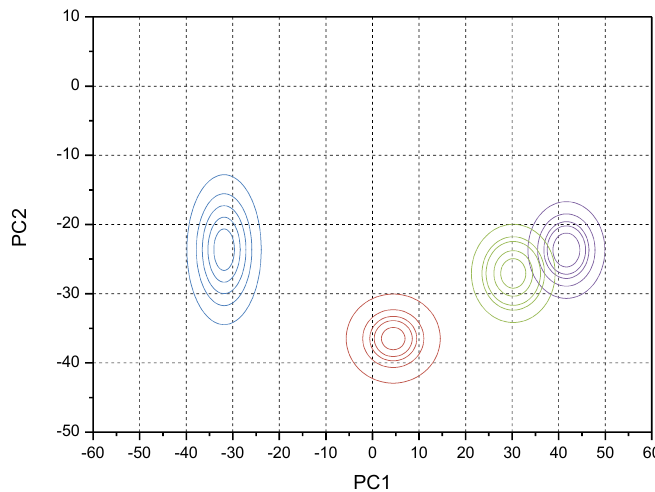
Figure 5. Liquor taste information cloud model division result (purple: jiang-flavor style; blue: feng-flavor style; green: nong-flavor style; brown: mild-flavor style).